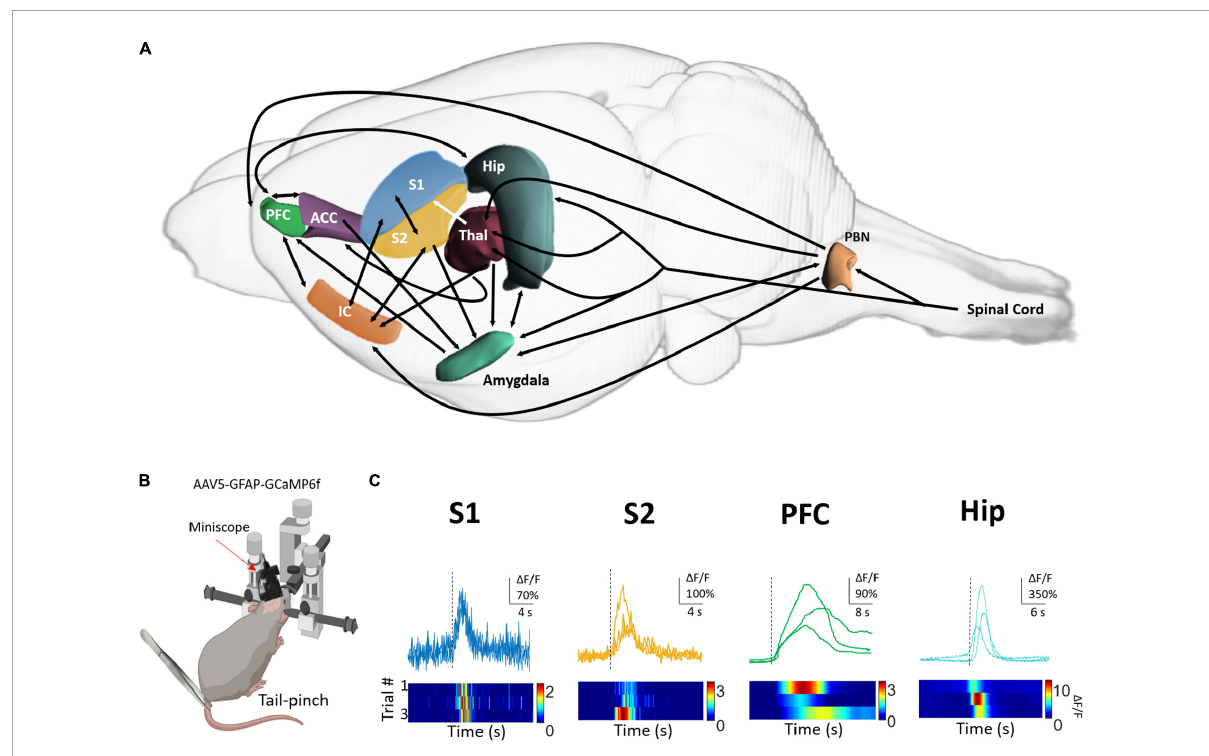
FIGURE1 Astrocytes respond to tail-pinched stimulation with calcium increases in pain-related brain areas. (A) Diagram showing regions (in color) and connections (arrows) of the nervous system that process nociceptive stimuli and are involved in pain perception. PFC, prefrontal cortex; ACC, anterior cingulate area; Hip, Hippocampus; S2, secondary somatosensory cortex; S1, primary somatosensory cortex; IC, insular cortex; Thal, thalamus. (B) Tail-pinch was applied with forceps to lightly anesthetized mice (0.5% isoflurane) expressing GCaMP6f in astrocytes located in S1, S2, PFC, and Hip. Representative traces of astrocyte calcium dynamics were monitored with one-photon Miniscope. Tail-pinch stimulation is indicated with a dotted black line (C) . The color maps show the calcium responses before, during, and after tail pinch stimulation. Basal fluorescence was considered as the calcium activity observed before the sensory